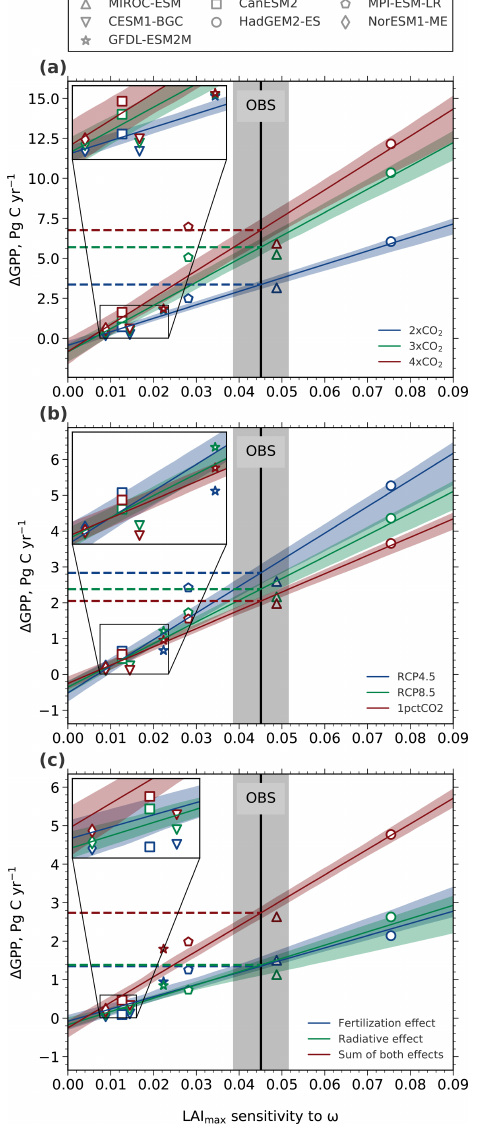
Figure 7. Linear relationships between the historical sensitivity of LAI max to ω and an absolute increase in GPP at different levels (a) , different time rates (b) , and the effects of rising CO 2 (c) . The solid black line depicts the observational sensitivity including the stan- dard error (gray shading). Each CMIP5 model is represented by a distinct marker (legend at the top). The colored lines show the best linear fits including the 68% confidence interval estimated by bootstrapping across the model ensemble. The colored dashed lines indicate the derived constraints on (cid:49) GPP. (a) Absolute changes in GPP at different levels of CO 2 : 2 × CO 2 (blue), 3 × CO 2 (green), and 4 × CO 2 (red). (b) Absolute changes in GPP for a rising CO 2 concentration from 380 to 535ppm at different time rates: RCP4.5 (90-year, blue), RCP8.5 (45-year, green), and 1pctCO2 (30-year, red). (c) Absolute changes in GPP due to the two disentangled ef- fects of CO 2 at 2 × CO 2 in idealized simulations: fertilization effect (esmFixClim1, blue), radiative effect (esmFdbk1, green), and the sum of both effects